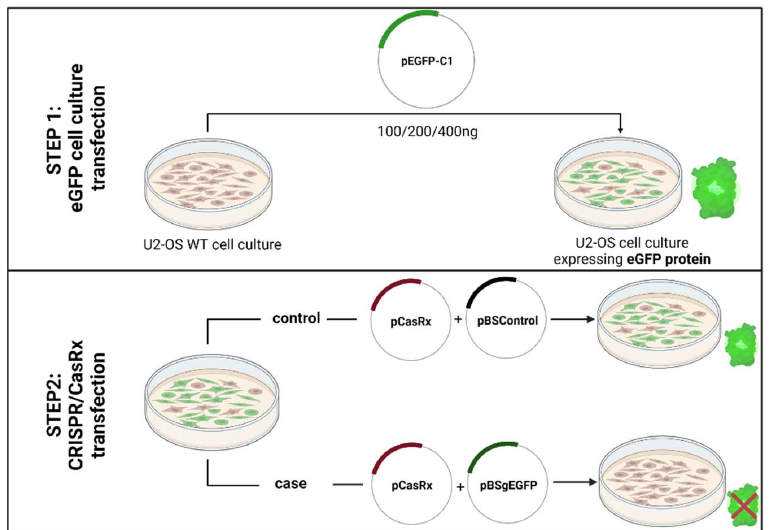
Figure 1. Schematic representation of the transfection protocol. Created with Biorender.com (ac- cessed on 24 August 2021). on 24 August